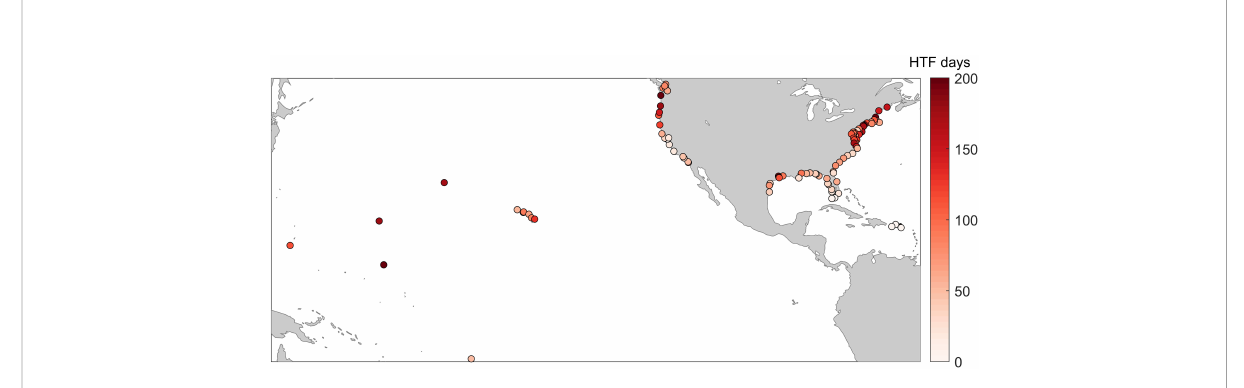
FIGURE 3 The total number of HTF days from 1997-2019 at each of the 98 NOAA tide gauges. Note that the days at some stations exceed